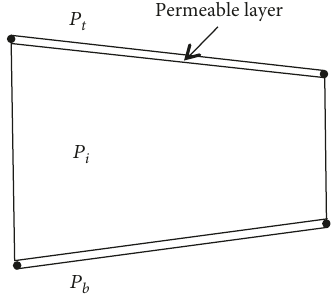
Figure 2: The leakage coe ffi cient is shown as a permeable